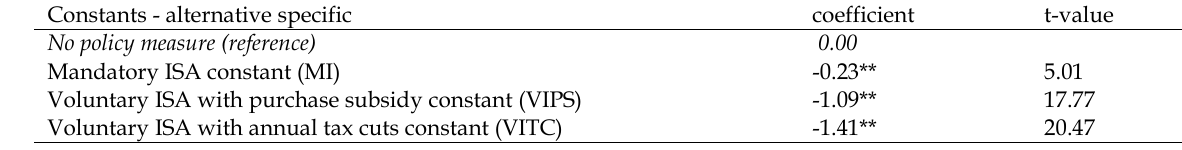
Table 2. Estimated parameters (MNL